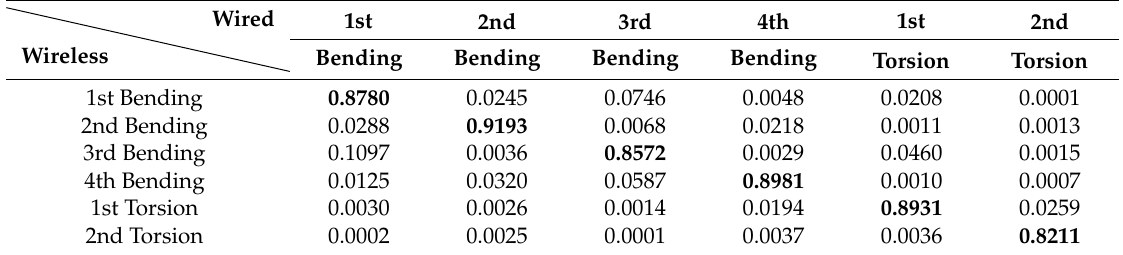
Table 4. Compare to mode vector of model bridge (wired vs.